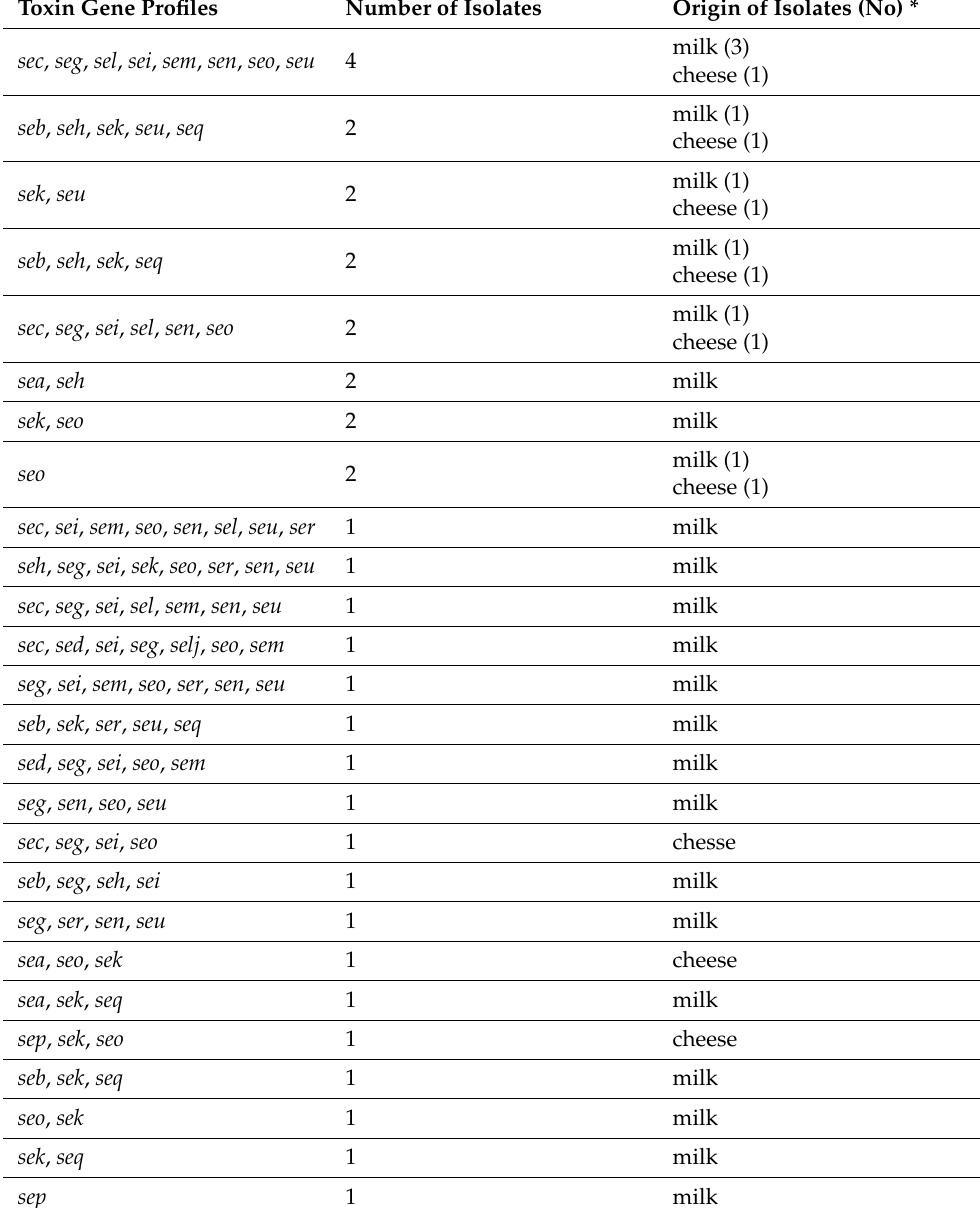
Table 1. Toxin gene